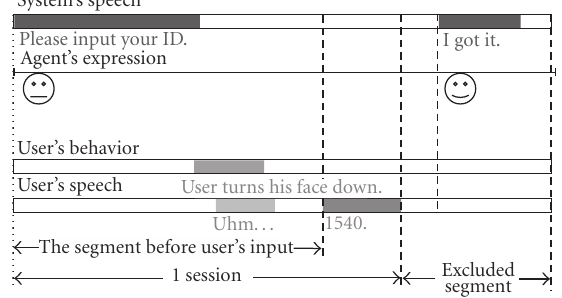
Figure 3: Outline of dialog